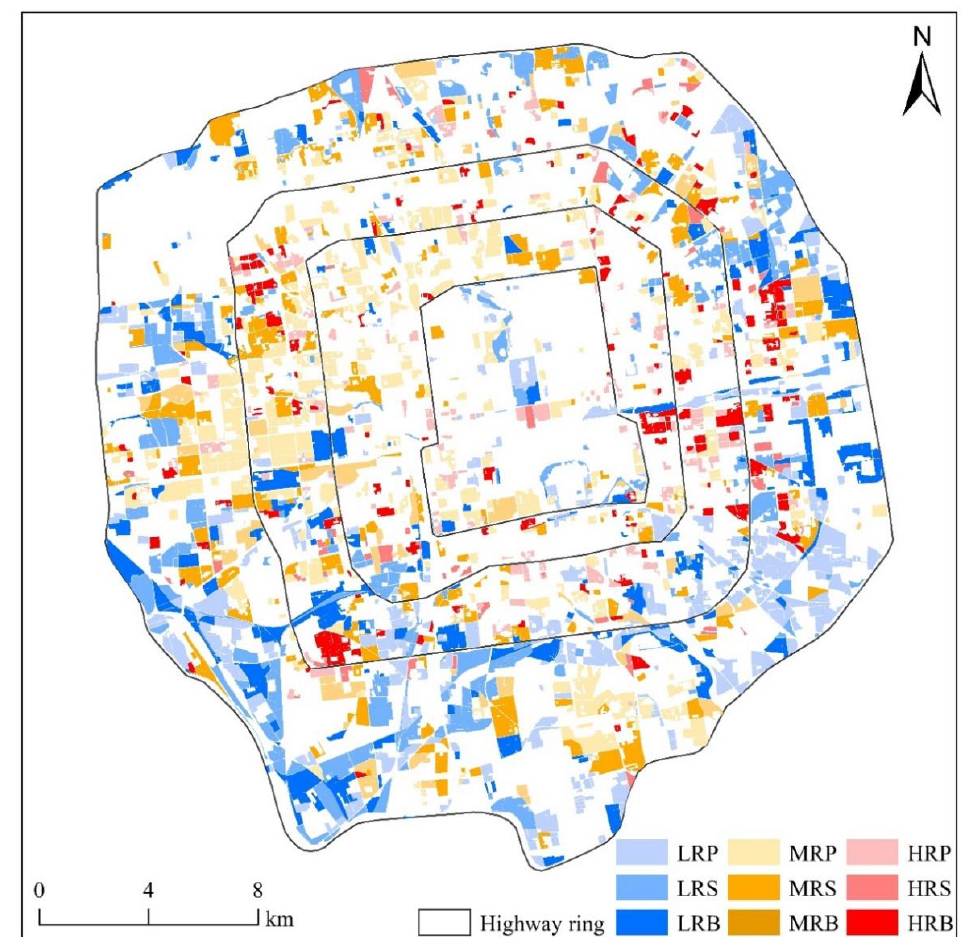
Figure 3. Spatial distribution of urban block samples. Table 2. The number of different types of urban block samples.